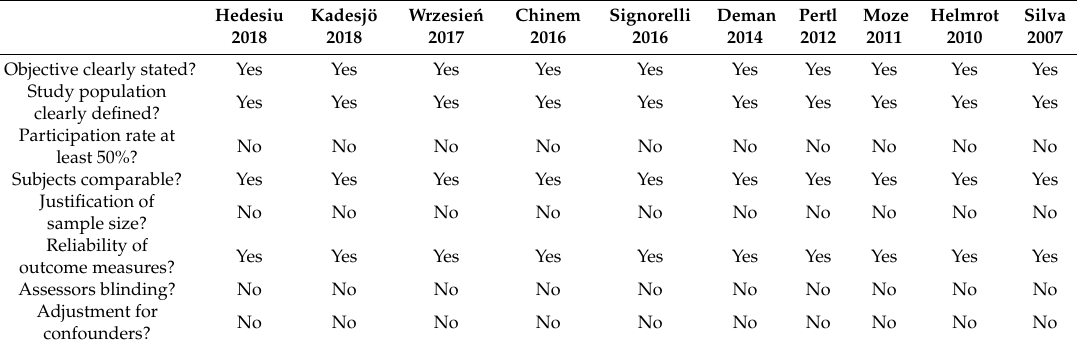
Table 9. Methodological quality appraisal of studies regarding radiation dose